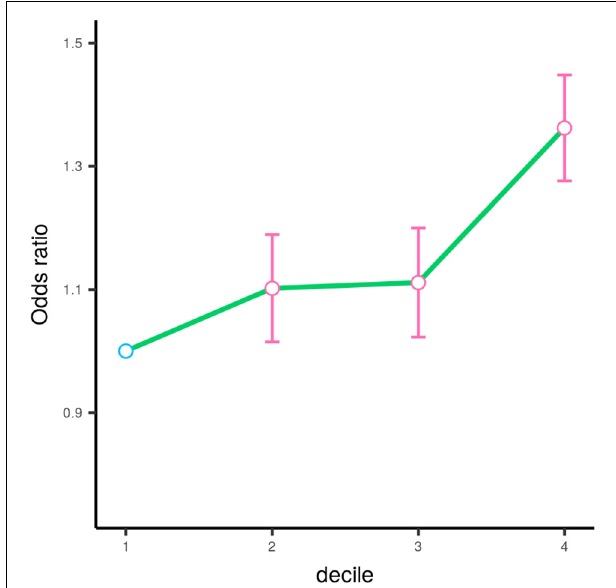
FIGURE 2 | Odds ratios (OR) by the quartile of polygenic risk score estimated based on the top three SNPs. The circle denotes the estimated value of odds ratio. The error bar represents the 95% confidence interval for the odds ratio estimation. The circle is colored in pink ( p < 0.05) and blue ( p > 0.05) according to its corresponding respective p